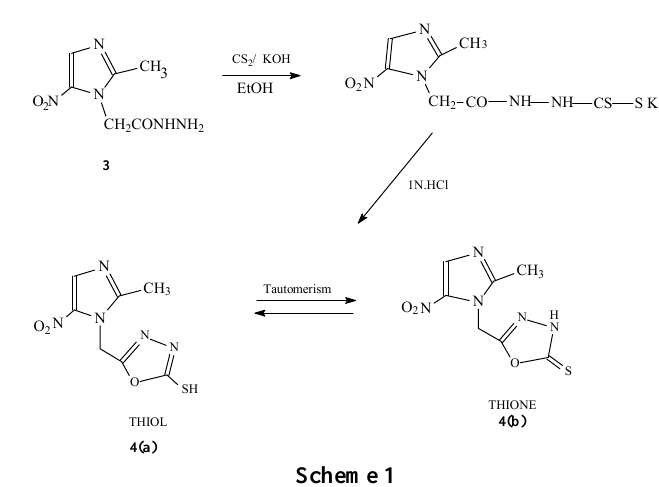
Table 1. Analytical data of MNIMOT(L) and its metal complexes Compounds